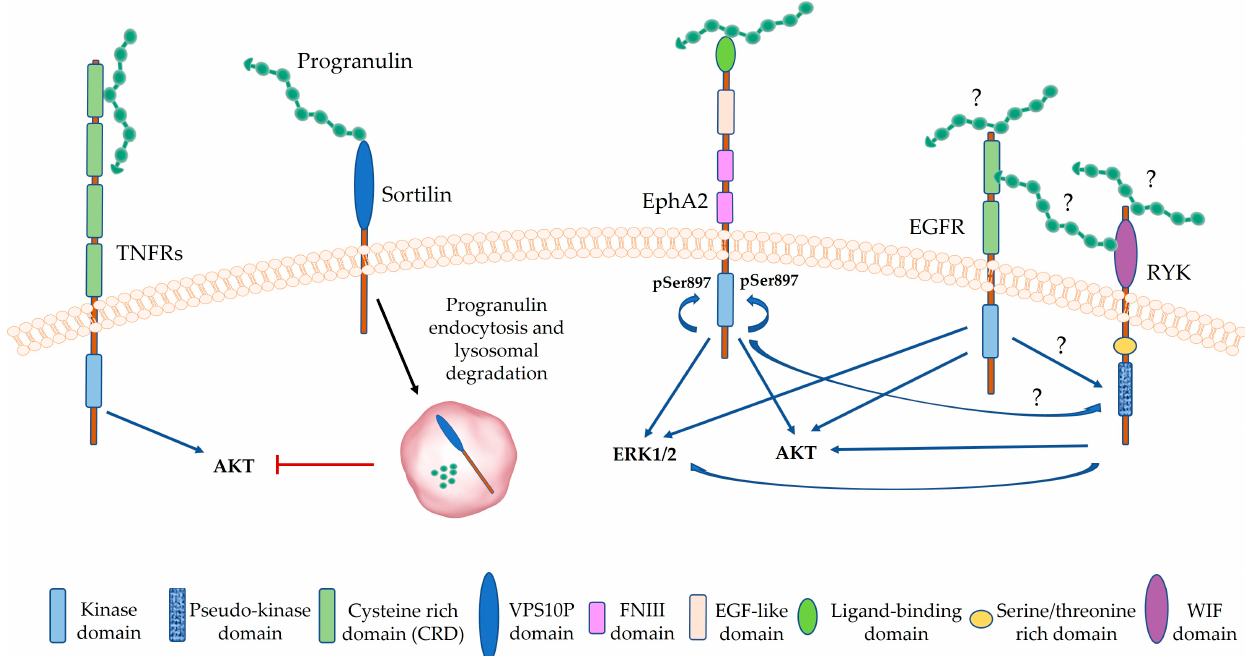
Figure 2. Progranulin signaling in cancer. Progranulin oncogenic signaling is highly dependent on progranulin-dependent activation of AKT and/or MAPK signaling pathways. In colorectal cancer, progranulin promotes AKT activation in a TNFR2-dependent manner. In prostate cancer, sortilin acts as a negative regulator of progranulin by promoting progranulin internalization and degradation, leading to the inhibition of the AKT pathway. In turn, progranulin mediates sortilin ubiquitination and degradation to sustain its pro-oncogenic activity. In bladder cancer, progranulin binds to and activates EphA2, leading to AKT and MAPK activation. In turn, AKT and MAPK sustain EphA2 phosphorylation at Ser897. In mesothelioma, progranulin-dependent activation of the AKT and MAPK signaling pathways relies on EGFR and RYK. Progranulin directly interacts with TNFRs, sortilin and EphA2. Whether progranulin promotes EGFR and RYK phosphorylation and activation directly by physically interacting with the receptors, or in an indirect manner, or whether progranulin promotes the formation of a complex including EGFR, RYK and EphA2 requires further investigation.